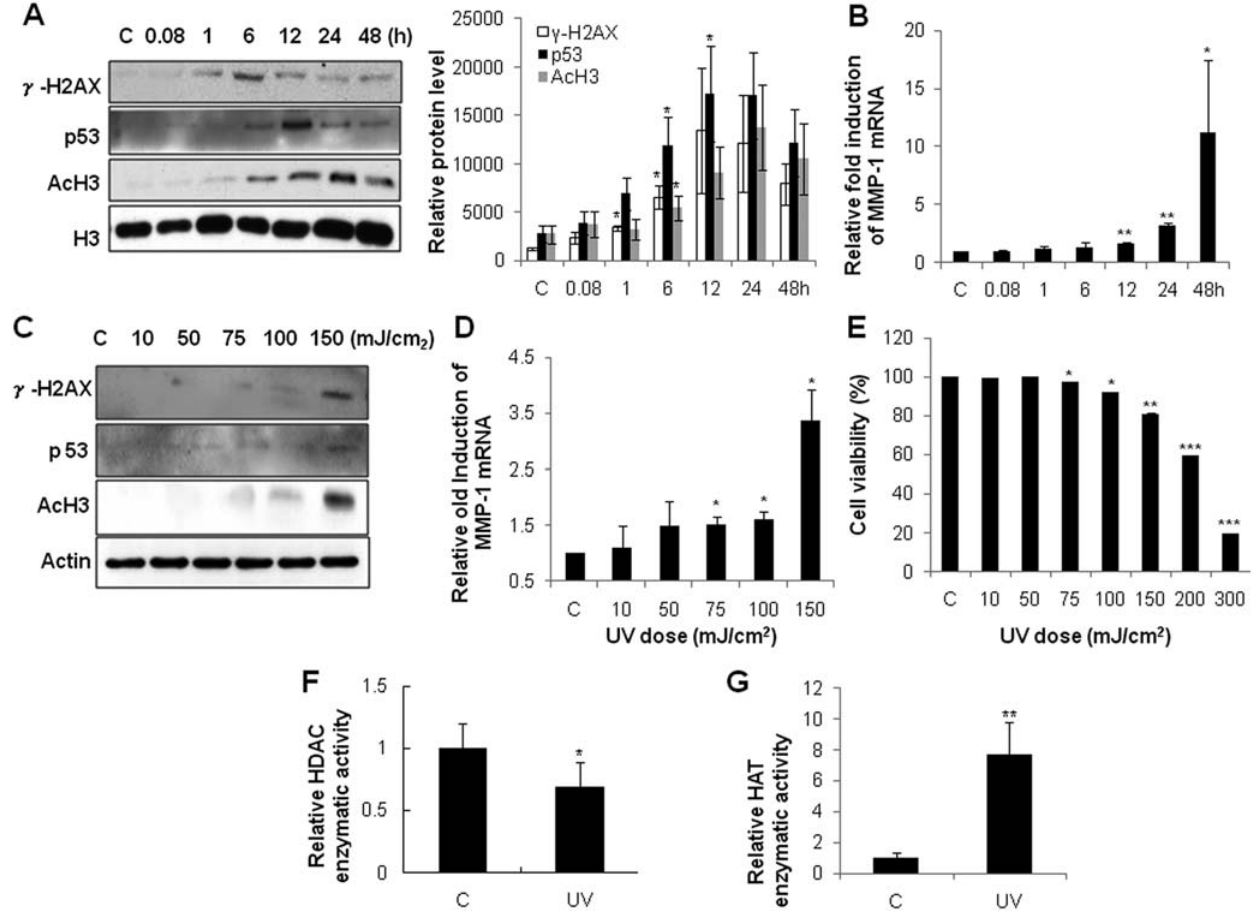
Figure 1. UV irradiation increased c -H2AX, p53, acetyl-H3 levels and MMP-1 expression in HDFs. A, HDFs were UV-irradiated with 150 mJ/cm 2 and cells were incubated for the indicated time. c -H2AX, p53, and acetyl-H3 levels in total cell lysates were analyzed by western blotting ( left panels ). Bar graphs ( right panels ) show quantitative analysis of scanning densitometric values of c -H2AX, p53 and acetyl-H3 as ratios to b -actin or histone H3, which were used as a loading control. Data shown are representative of four independent experiments. B, Time-dependent increases of MMP-1 mRNA expression following 150 mJ/cm 2 of UV irradiation in HDFs. Expression of MMP-1 mRNA was detected by quantitative real-time RT-PCR and was normalized to the respective 36B4 mRNA. C, UV induced c -H2AX, p53 level, acetyl-H3 in a dose-dependent manner (0–150 mJ/cm 2 ). The levels of c -H2AX, p53 and acetyl-H3 were measured by western blot analysis at 6 h after UV irradiation. D, MMP-1 mRNA (0–150 mJ/cm 2 ) expression was quantified by real-time RT-PCR and was normalized to the respective 36B4 mRNA. E, Cytotoxic effects induced by increasing doses of UV irradiation (0–300 mJ/cm 2 ) on HDFs measured by a MTT assay. F, Total cellular HDAC enzymatic activity was measured using an HDAC assay kit in untreated control HDFs or in HDFs UV-irradiated for 6 h. G, HAT activity in nuclear lysates of HDFs was determined after UV-irradiation with an indirect ELISA that detects acetyl residues. Values represent the mean 6 SEM of data from three independent experiments. C: control, UV: UV- irradiated cells, *P , 0.05, **P , 0.01, ***P , 0.001 vs.